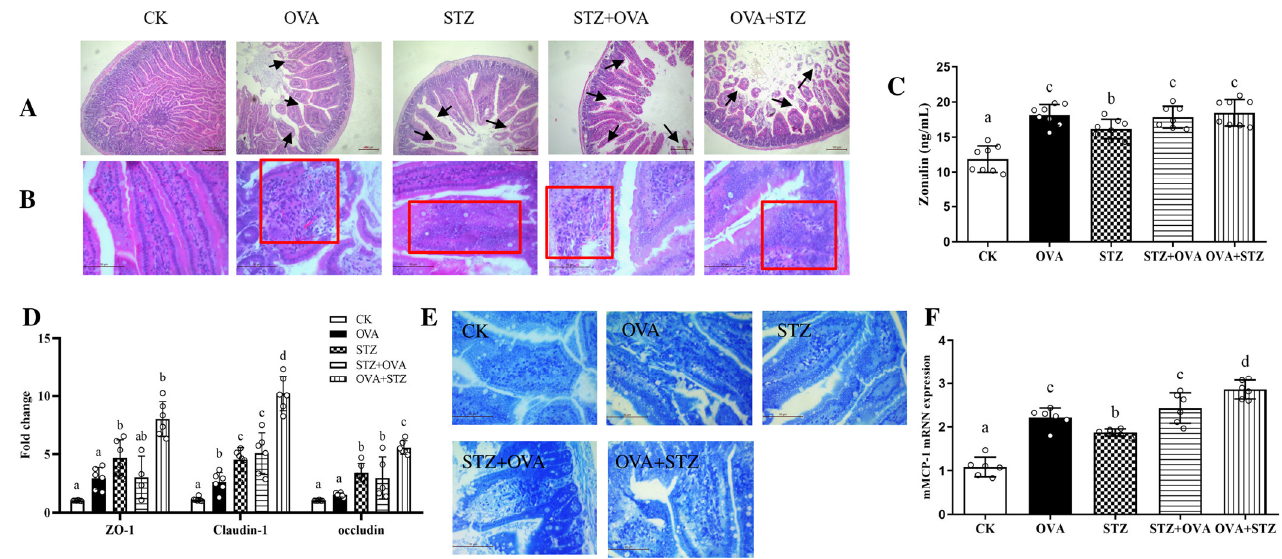
Figure 5. Food allergy affects diabetes by promoting jejunal barrier destruction. ( A ), H&E staining of jejunum (scale bar =100 μm). The arrows in the Histo means significant changes in intestinal villi structure. ( B ), H&E staining of jejunum (scale bar = 50 μm). ( C ), Serum levels of Zonulin. ( D ), mRNA expression of tight junction proteins (ZO-1, Claudin-1, occludin) in jejunum. ( E ), Toluidine blue staining of jejunum (scale bar = 50 μm). ( F ), mRNA expression of mMCP-1 in jejunum. The error bars indicated the mean ± SEM. n = 6. Different lowercase letters in the figure represent significant differences between the groups ( p < 0.05 by one-way ANOVA followed by SNK).